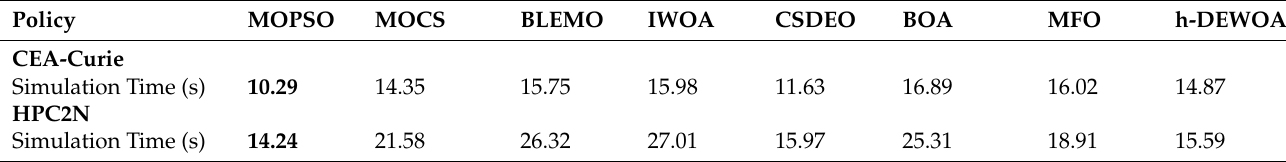
Table 21. Mean simulation time of scheduling algorithms for the second series of